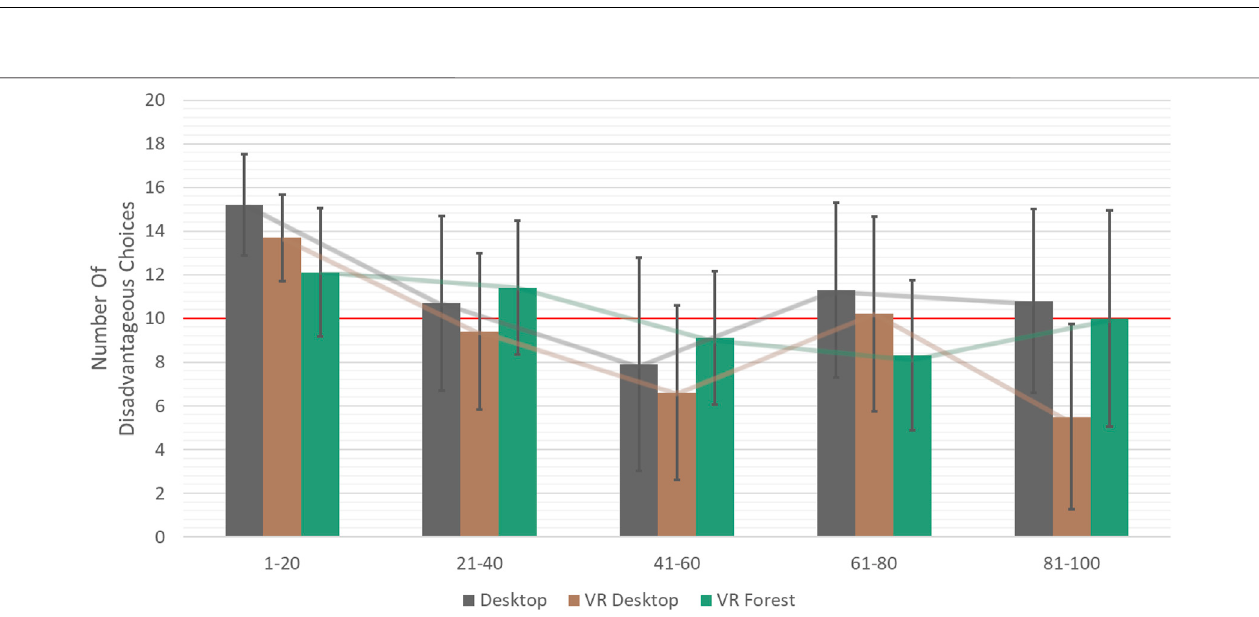
FIGURE 8 | Comparison of the mean number of disadvantageous cards drawn per 20 game rounds. The error bars denote the standard deviation. The red line indicates the threshold above which more bad than good decisions were made.